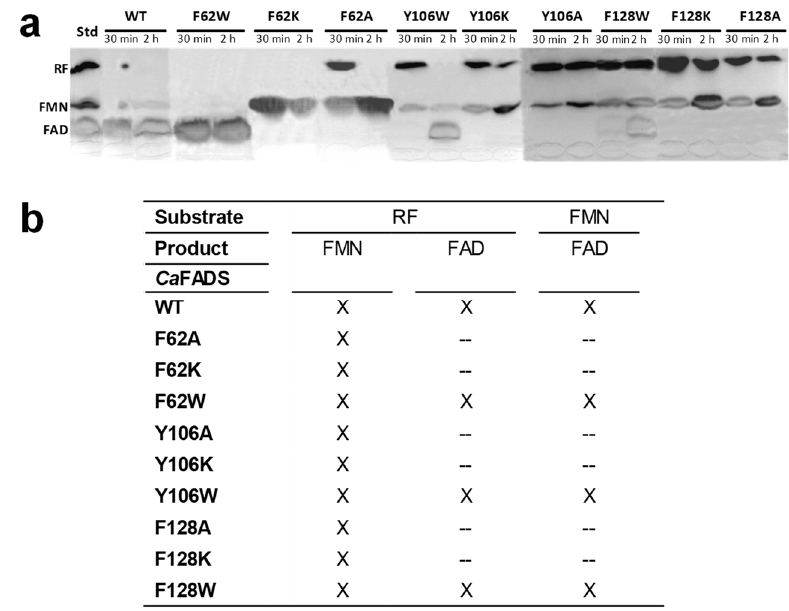
Figure 4. Profiles of the reactions of Ca FADS variants with its substrates. ( a ) Resolution by TLC of the products of the riboflavinkinase (RFK) activity of Ca FADS variants after incubation of reaction mixtures for 30 min and 2 h at 25 °C. ( b ) Summary of product formation after incubation of Ca FADS variants with RF or FMN at 25 °C during 2 h of reaction. Cross and hyphen indicate production and not detection, respectively, of the corresponding product. Reaction mixtures contained 200 nM of enzyme, 50 µ M of RF or FMN, and 0.2 mM of ATP in 20 mM PIPES, 10 mM MgCl 2 , pH 7.0. Standard markers contain 50 µ M of each of the flavins (RF, FMN, and FAD) incubated in similar conditions.